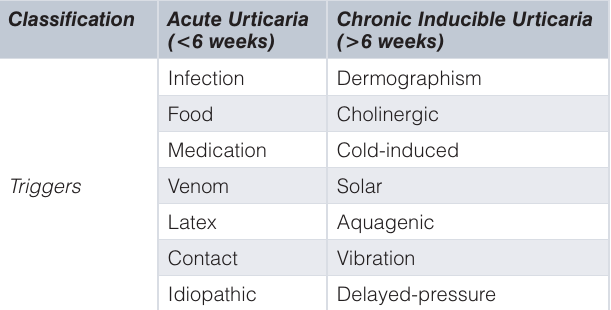
Table 1. Triggers of Acute Urticaria and Chronic Inducible Urticaria. The triggers of acute and chronic urticaria are different and are outlined in this